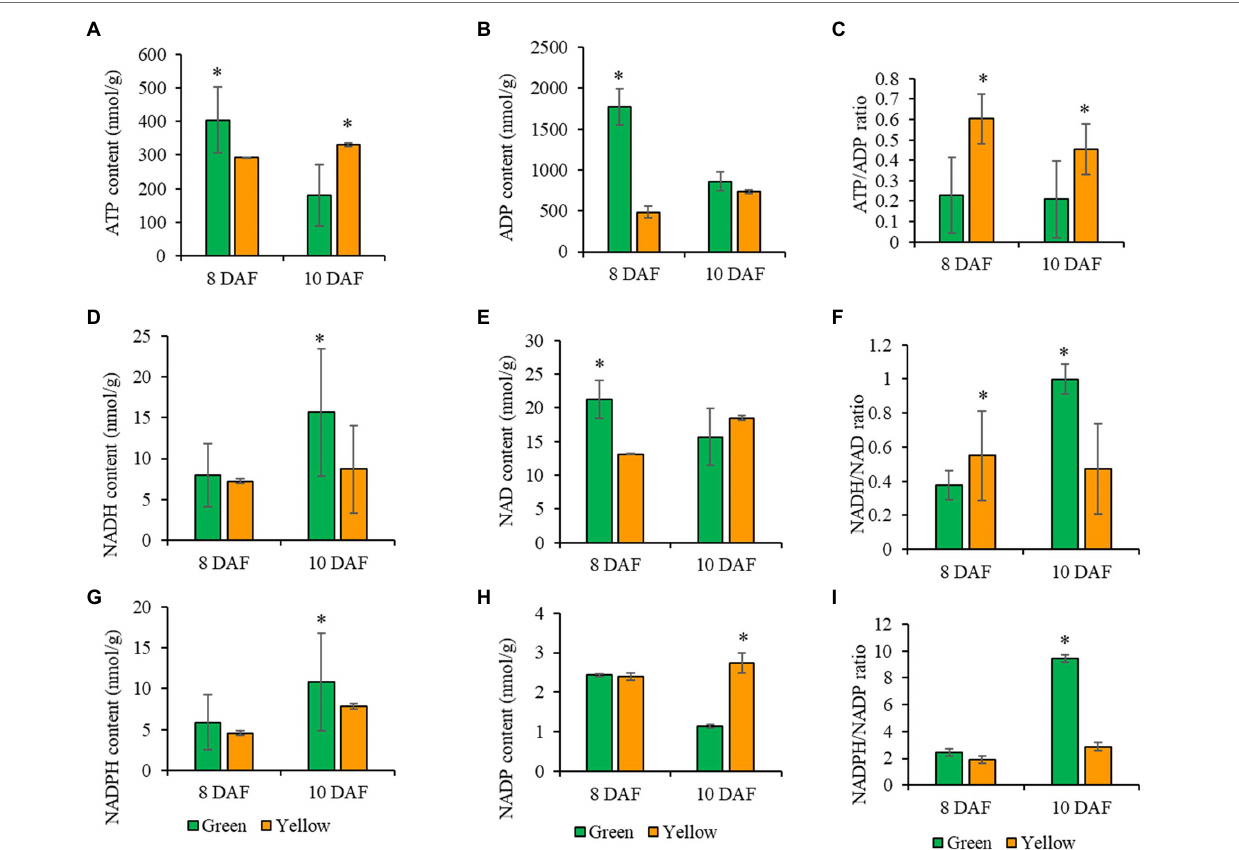
FIGURE 6 | Measurement of pyridine nucleotides and ATP analyses of photosynthetic and non-photosynthetic seeds at 8, and 10 DAF. (A) ATP content. (B) ADP content. (C) ATP/ADP ratio. (D) NADH content. (E) NAD content. (F) NADH/NAD ratio. (G) NADPH content. (H) NADP content. (I) NADPH/NADP ratio. Green bar represents photosynthetic seeds, and the orange bar represents non-photosynthetic seeds. Values are means ± SD ( n = 3 biological replicates). Statistical significance was analyzed using a two-sided Student t -test. The asterisk indicates a significant difference ( * p <